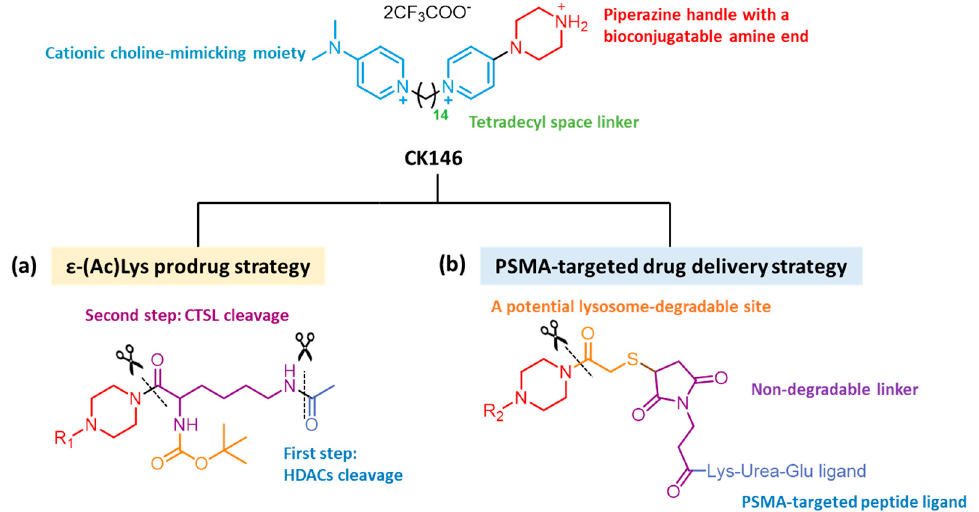
Figure 9. Design of two drug development strategies based on CK146. ( a ) ε -(Ac) Lys prodrug strategy; ( b ) PSMA-targeted drug delivery strategy.